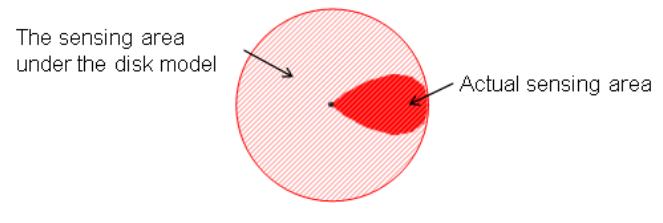
Figure 1. The sensing area of a directional sensor under the disk model.